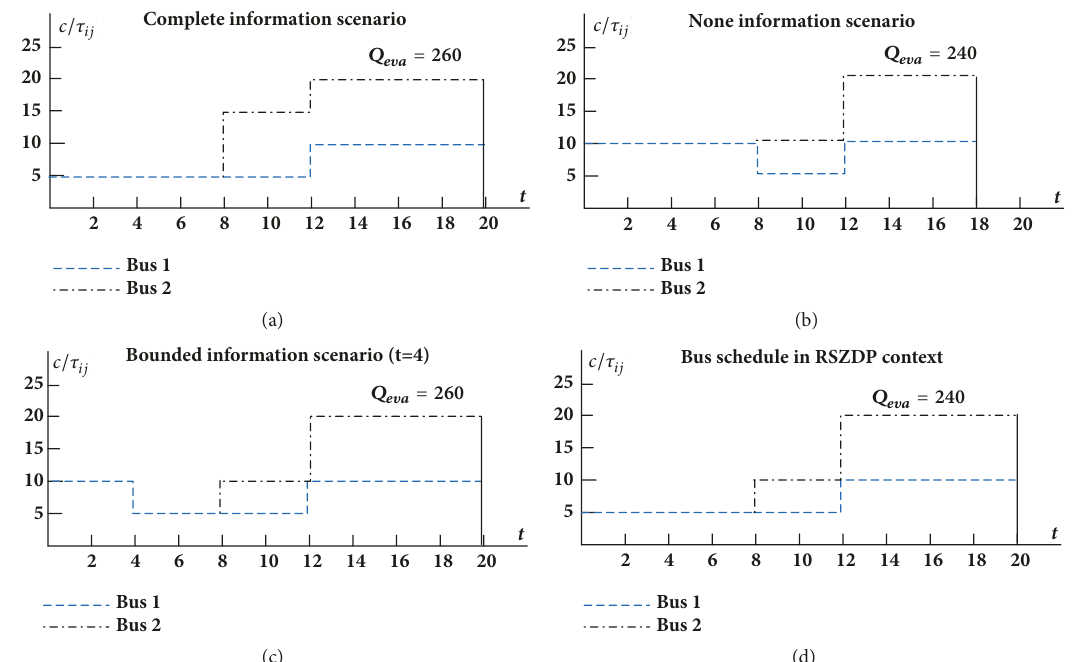
Figure 7: Trip orders of bus 1 and bus 2 under different scenarios with 𝑡 2 =